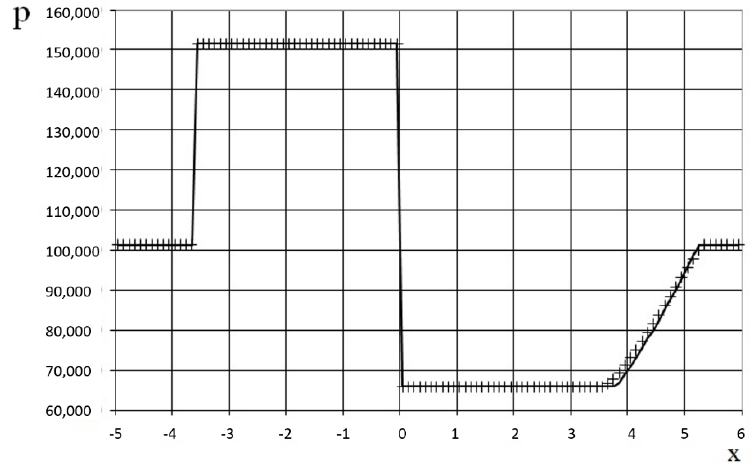
Figure 28. Pressure plot for the problem (53): the exact solution (line), and the present method (cross).